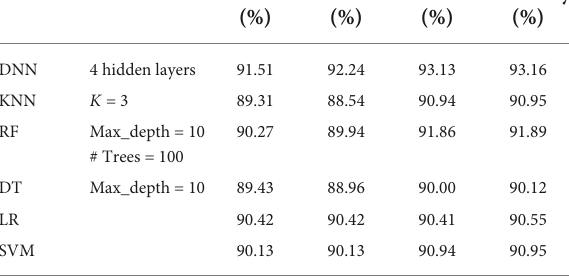
TABLE 5 Performance analysis of classifiers on DS1 dataset.